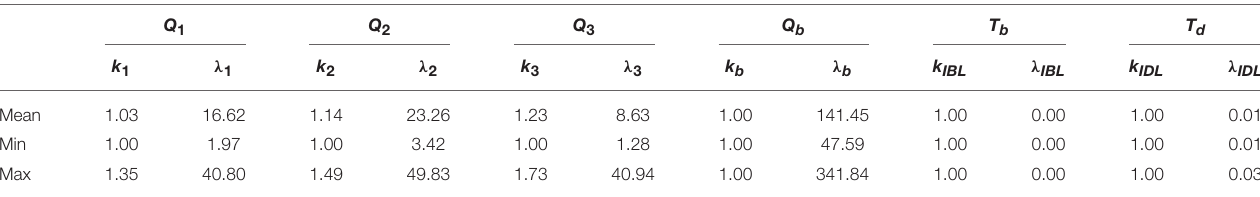
TABLE 2 | The mean and range of the parameters used in the distributions describing the length of drinks ( Q 1 , Q 2 , Q 3 ), length of time between drinks ( T b , T d ), and length of bouts ( Q b ).